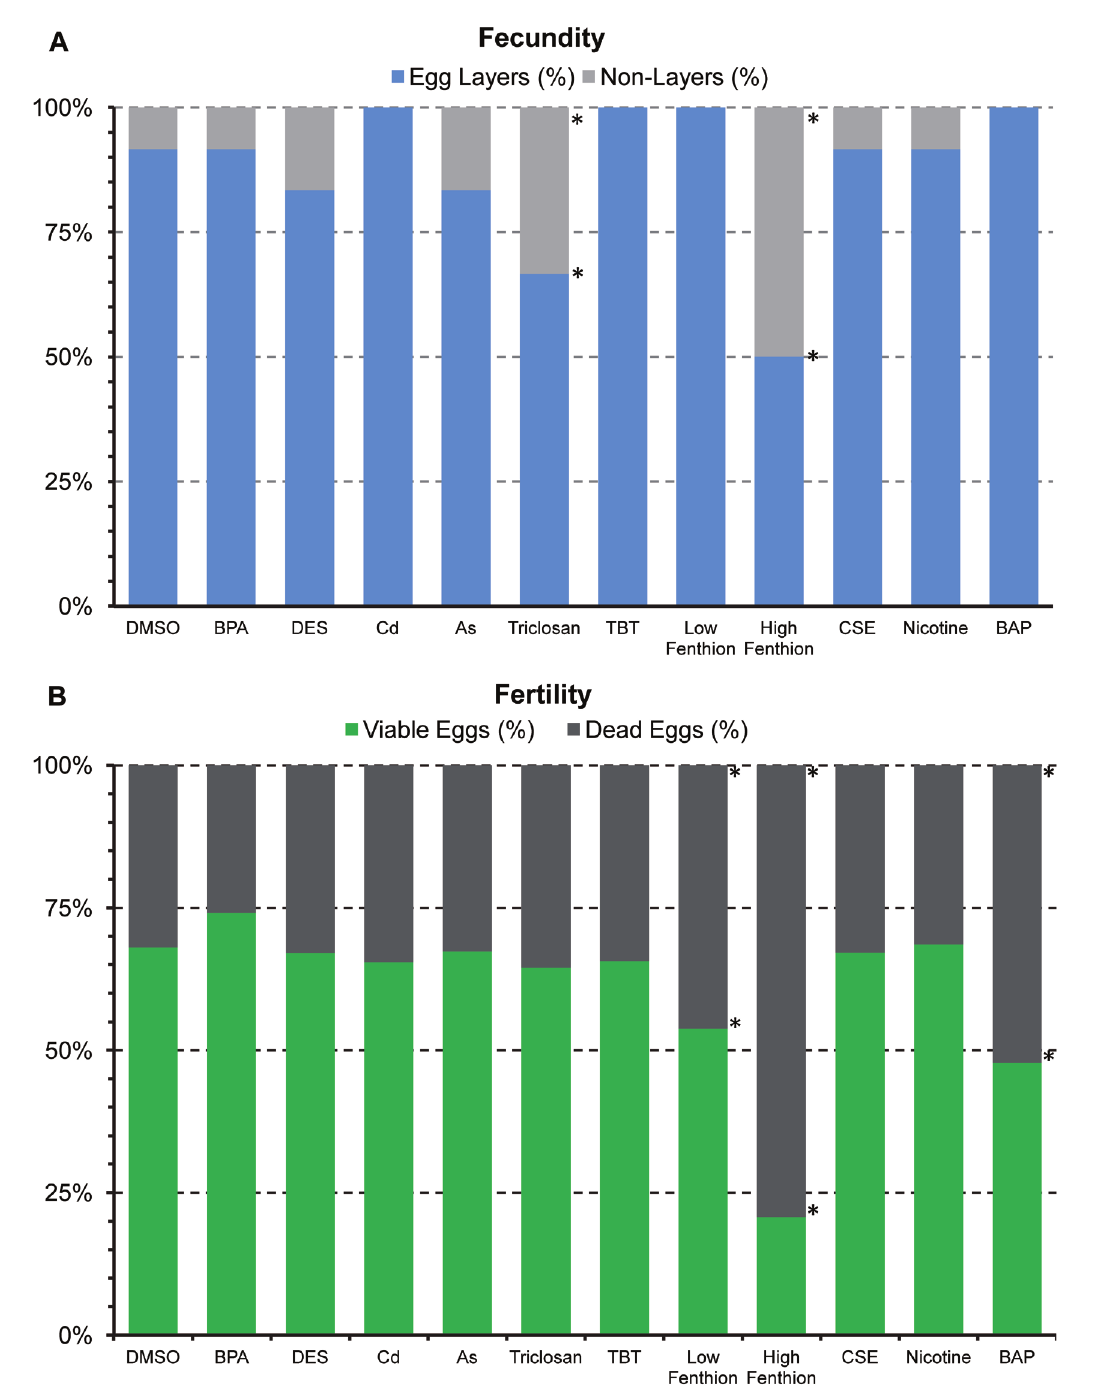
Figure 2. Effects of teratogens on fecundity ( A ) and fertility ( B ). The overall percentage of worms that laid eggs shown as fecundity and the overall percentage of viable and dead eggs as a measure of fertility. Asterisks indicate P